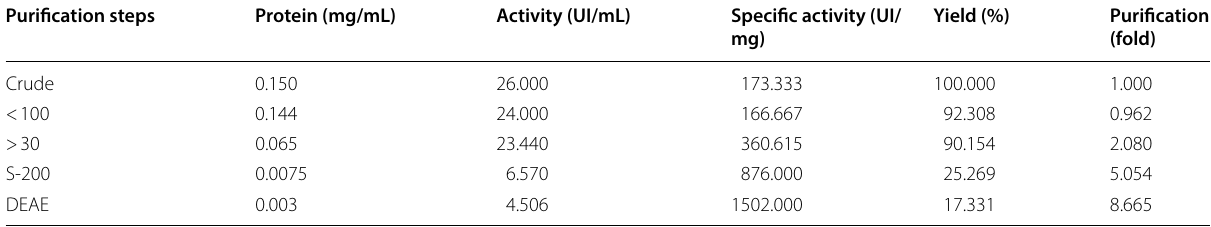
Table 4 Summary of purification steps of β-galactosidase from A. niger Purification steps